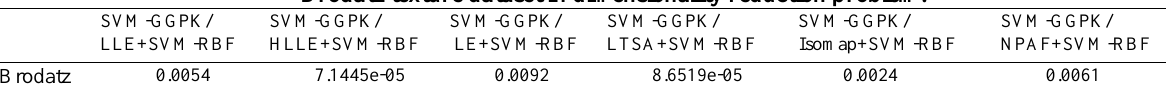
Table 10. p-value resulted by applying paired t-Test for comparison between SVM-GGPK and other compatitors on Brodatz texture dataset in dimensionality reduction